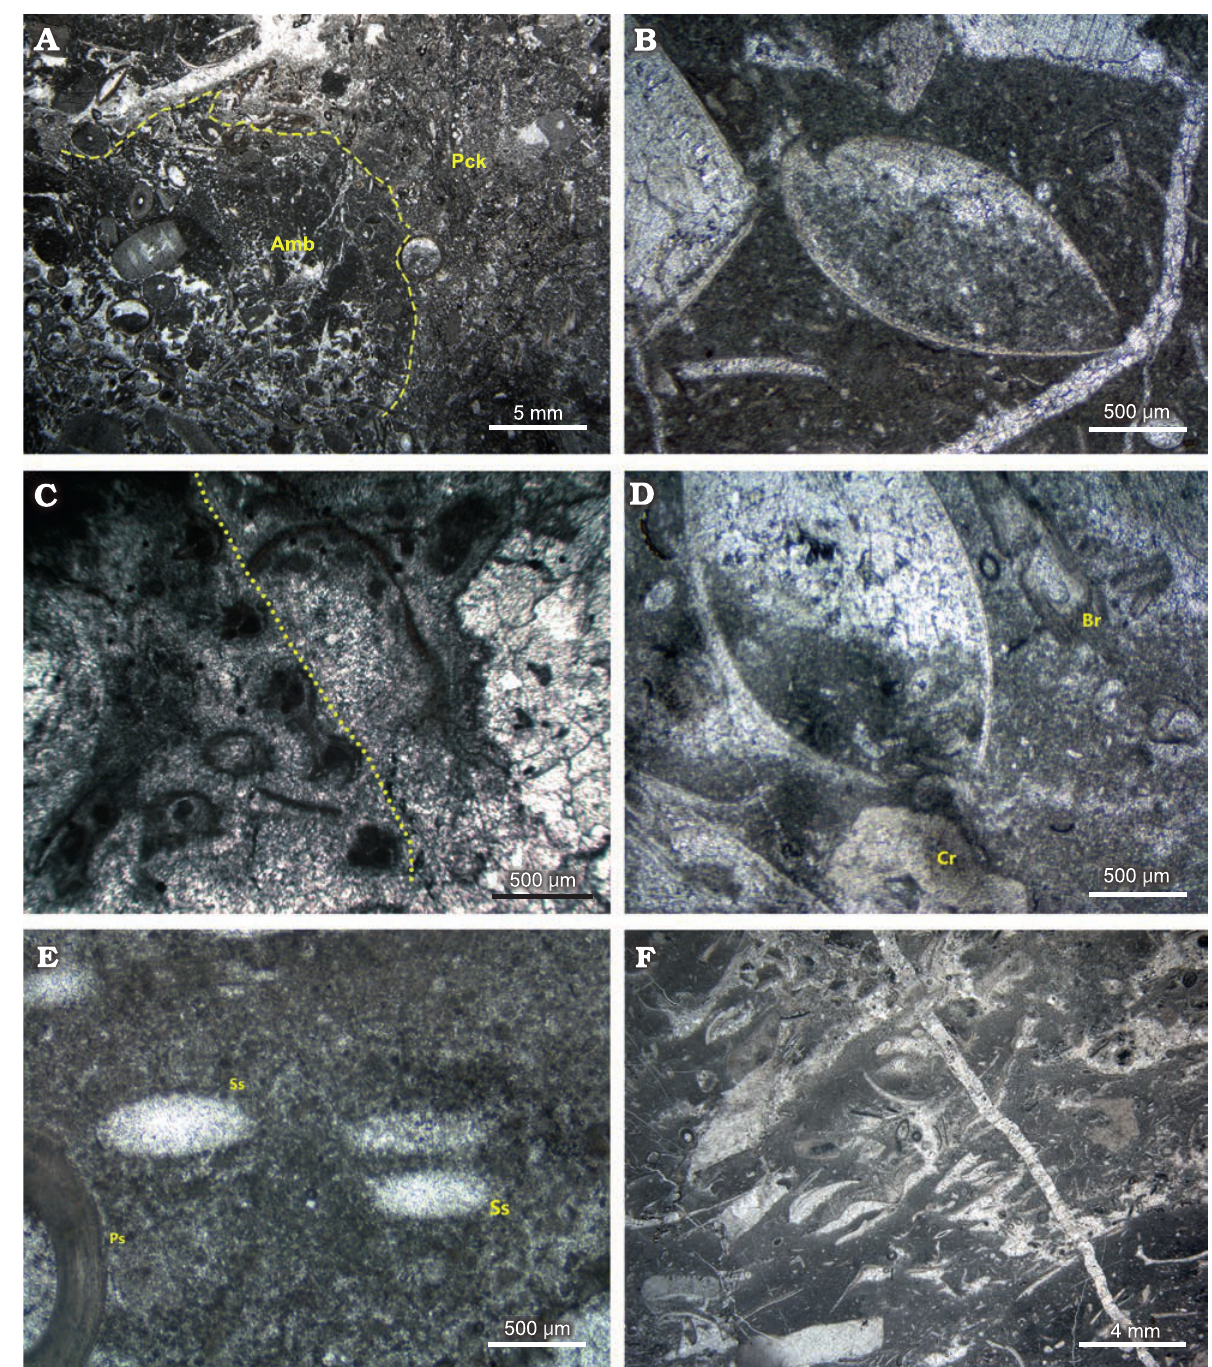
Fig. 5. Photomicrographs of petrographic thin sections from the Brigantian (uppermost Visean) mud mound complex of Ricklow Quarry (FA1, FA2, FA3), Monyash, England. A . Sample MPUM12295 (RCC89). Automicrite boundstone patch (Amb) within a packstone (Pck) with allomicrite, from a nodu- lar packstone bed at the base of the mound complex (FA1). Note more heavily recrystallized allomicrite with respect to automicrite. Plane polarisers. B . Sample MPUM12295 (RCC5). Articulated brachiopod shells embedded in automicrite from a tabular mound from the basal unit of the mound complex (FA1). Plane polarisers. C . Sample MPUM12295 (RCC65). Automicrite‒fenestellid bryozoan boundstone with abundant radiaxial fibrous marine and equant burial calcite cements from the mound complex core (FA2). Fenestellid frond marked by dotted line. Plane polarisers. D . Sample MPUM12295 (RCC85). Articulated brachiopod shells, crinoid ossicles (Cr), and fenestellid bryozoan fronds (Br) in automicrite boundstone from the mound complex core (FA2). The biconvex brachiopod specimen is in life position and lived attached to the crinoid ossicle in the mud underneath its umbo. Plane polar- isers. E . Sample MPUM12295 (RCC32B). Productide spine (Ps) and calcite-replaced siliceous sponge spicules (Ss) in automicrite boundstone from the mound complex core (FA2). Plane polarisers. F . Sample MPUM12295 (R6). Isoriented skeletal packstone with brachiopods and crinoids, with allo- and automicrite from the flank beds (FA3). Convex-up disarticulated brachiopod shells aligned along the flank beds forming shelter porosity, later filled by equant calcite cement. Plane